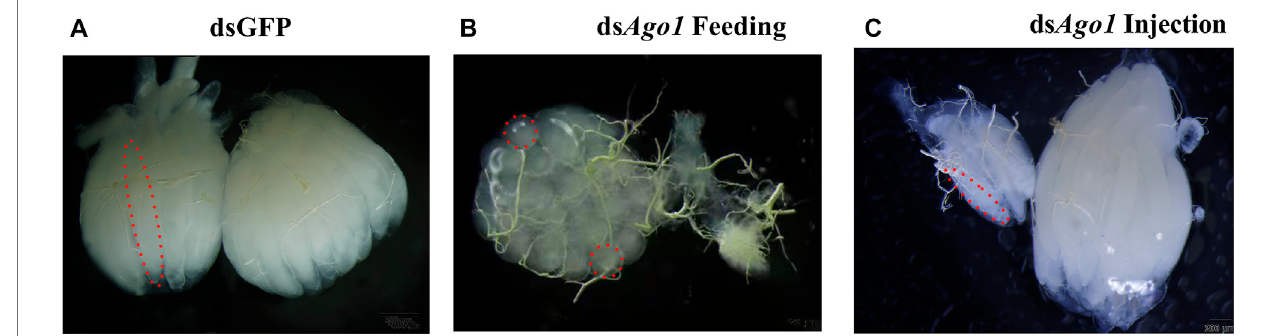
FIGURE 7 | Ovarian defects in the 14-day-old ovary after Ago1 silencing. Ovaries were dissected separately in 1 × PBS (pH 7.4) and visualized under a binocular stereomicroscope. Ovarioles are indicated by dashed red lines. (A) Normal ovaries in dsGFP control. (B) ds Ago1 feeding. One spheroid of the ovary had tiny round ovarioles,whilethedevelopmentofthe other one wassigni fi cantly arrested. (C) ds Ago1 injection. One spheroid ofthe ovaryhad long but few ovariolescompared tothe other one which developed